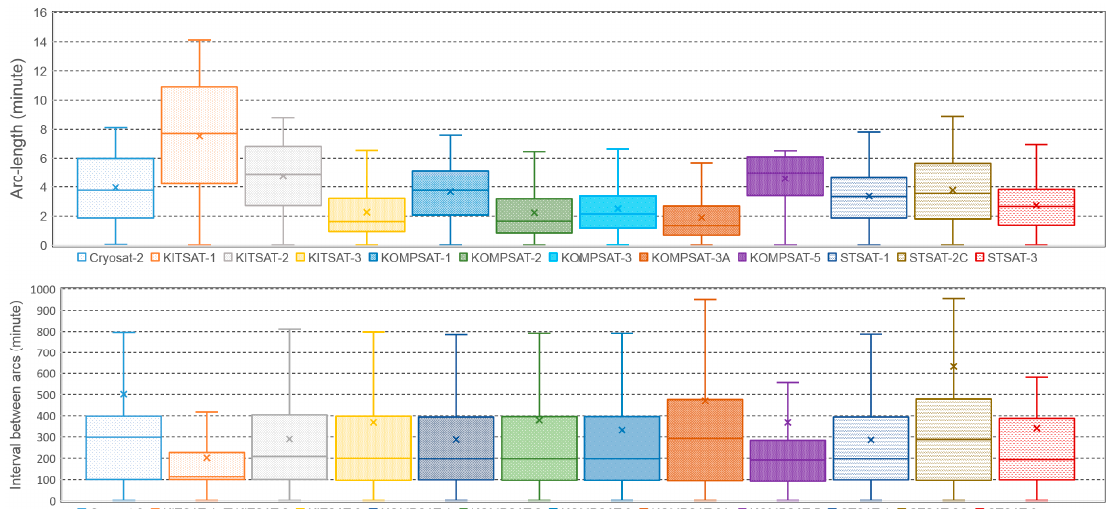
Figure 7. Statistics of the length of the arc and interval between observation chances for 11 LEO targets of the OWL-Net and CRYOSAT 2 from the optical observation simulation for 2017. The mean value of lengths of the arc (arc-length) did not exceed 4 min, whereas the mean value of intervals between the optical observation chance was about 400 min.